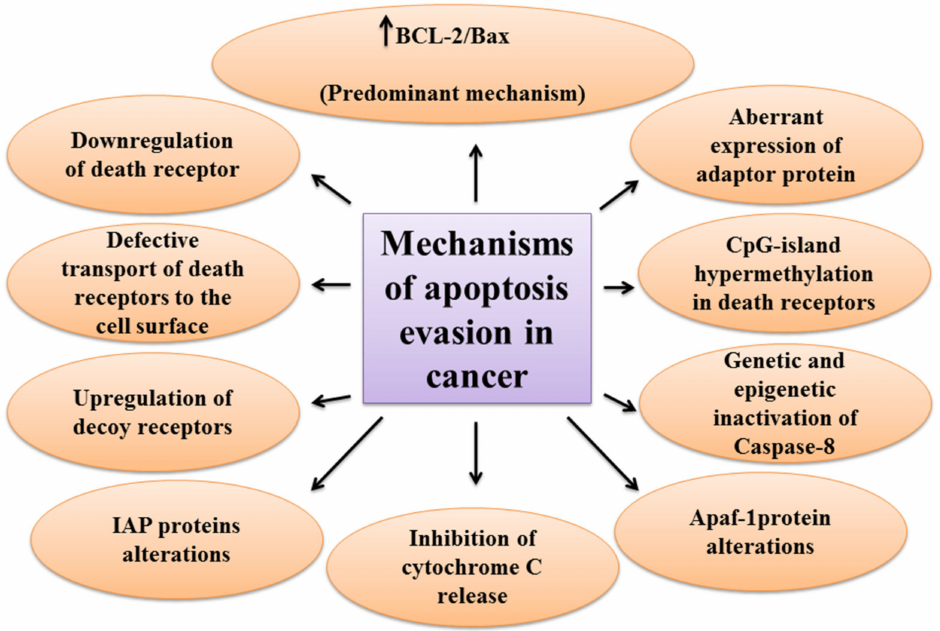
Figure 2. A schematic representation of the different mechanisms of apoptosis evasion used by